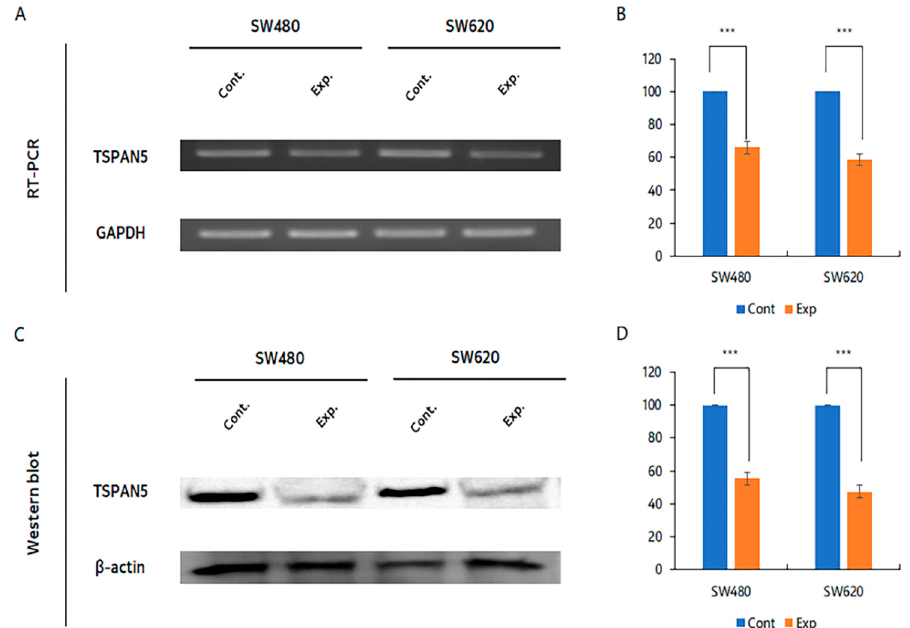
Figure 2. Confirmation of inhibition of colon cancer cell lines by siTSPAN5. ( A ) Confirmation of cell line inhibition using RT-PCR. ( B ) Relative mRNA expression graph between control and siTSPAN5 cell lines (*** p < 0.001). ( C ) Confirmation of cell line inhibition using Western blotting. ( D ) Relative protein expression graph between control and siTSPAN5 cell lines (*** p <